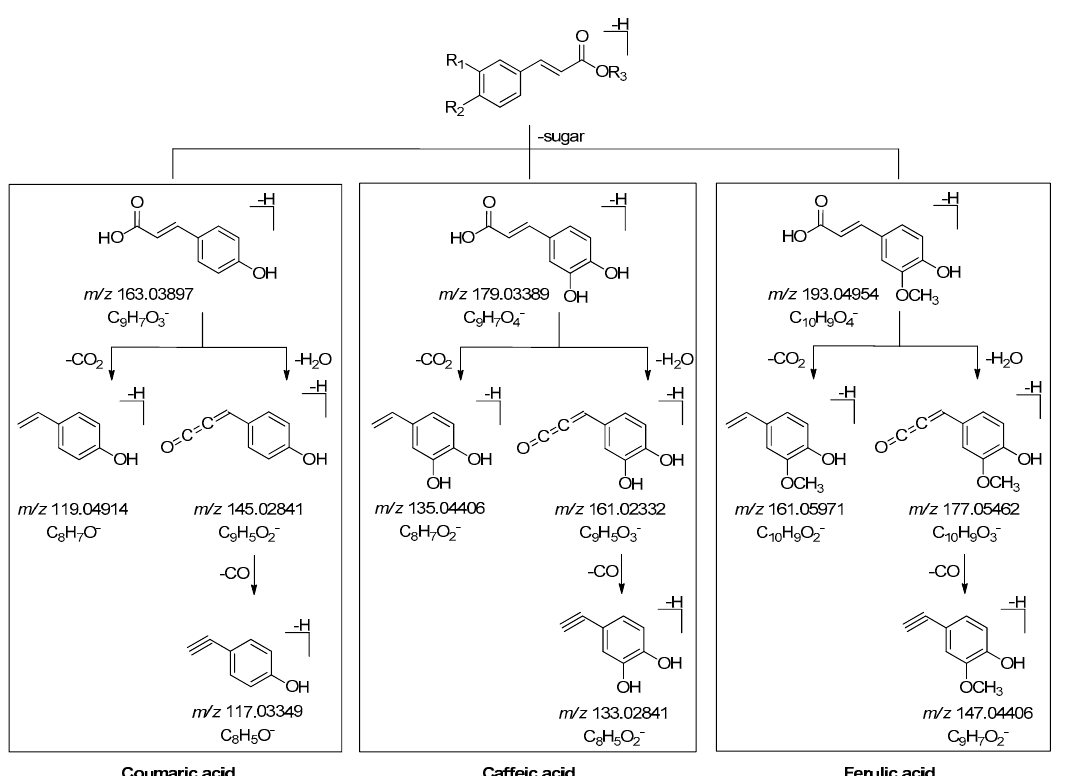
Figure 12. The proposed fragmentation pathways of coumaric acid, caffeic acid, and ferulic acid glycosides.